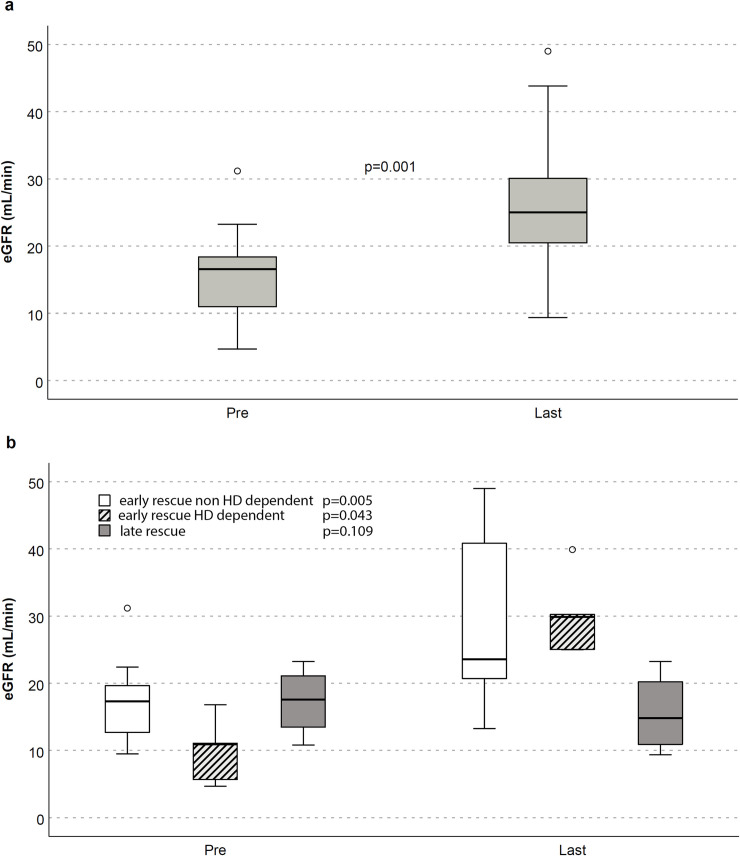
eGFR (CKD-EPI formula) before Belatacept association (pre) and at last follow-up (last) in overall population (panel a) and early- or late-converted patients (panel b).